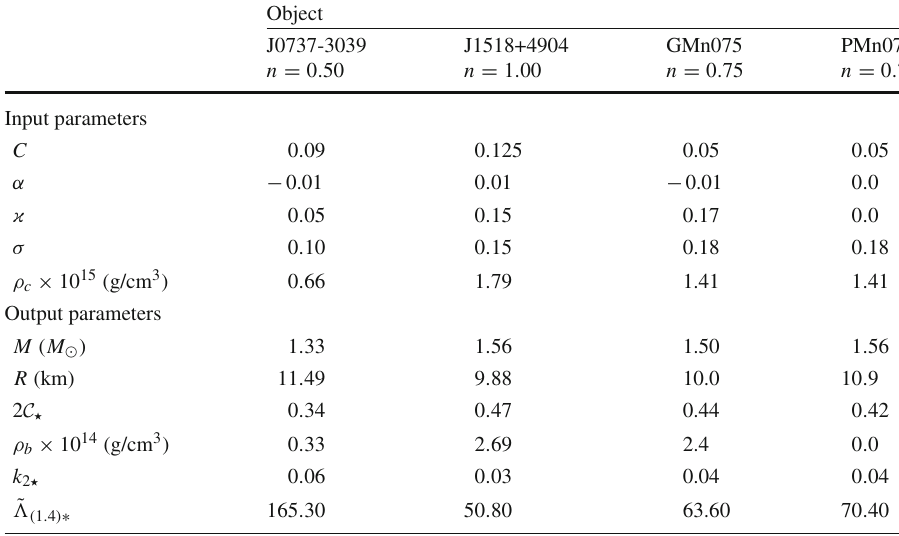
Table 1 Parameters for the numeric solution of the Master Lane–Emden Eqs. (14)–(15), modelling two NS candidates: the Pulsar J0737-30309, the Pulsar J1518+4904, a Generic Model of the compact star (GMn075) and a Polytropic model (PMn075), which correspond to the case α = β = 0 [96]. The output parameter displayed are: total mass M , total radius R , NS compactness C (cid:9) at surface, central density ρ c , boundary density ρ b , the mass-weighted dimensionless tidal polarizability, ˜ (cid:8) ( 1 . 4 ) ∗ , and Love number k 2